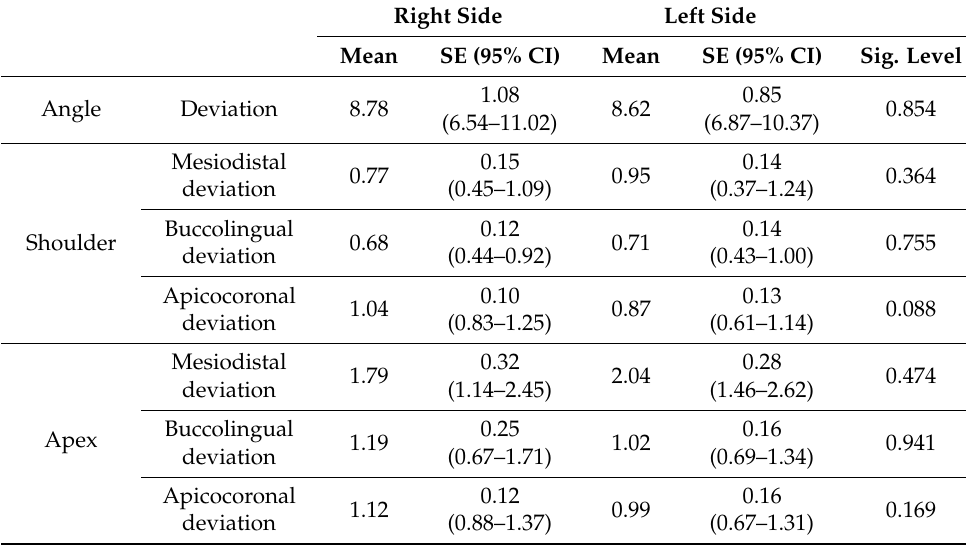
Table 6. Deviations between the planned and achieved implant position depending on the sides. Right side (N = 24) Left side (N = 28). Angle variance ( ◦ ). Linear deviation (mm). Kruskal–Wallis test with a significance level of p < 0.05.